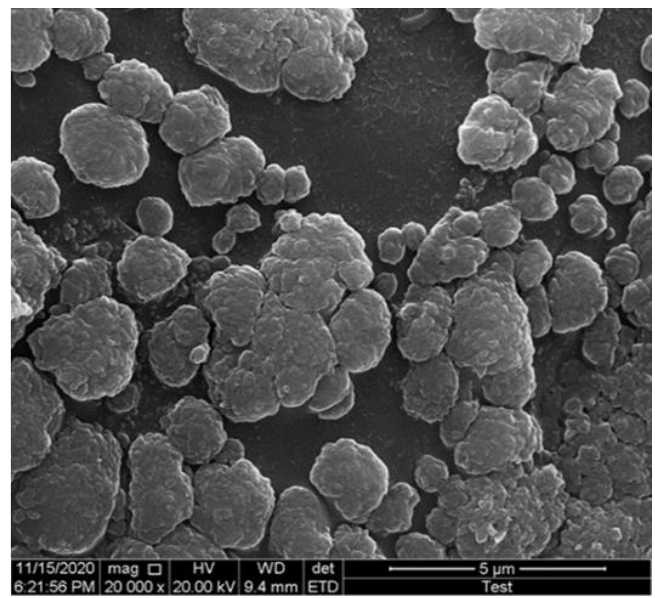
Figure 1. SEM micrograph of glutaraldehyde cross-linked chitosan beads.